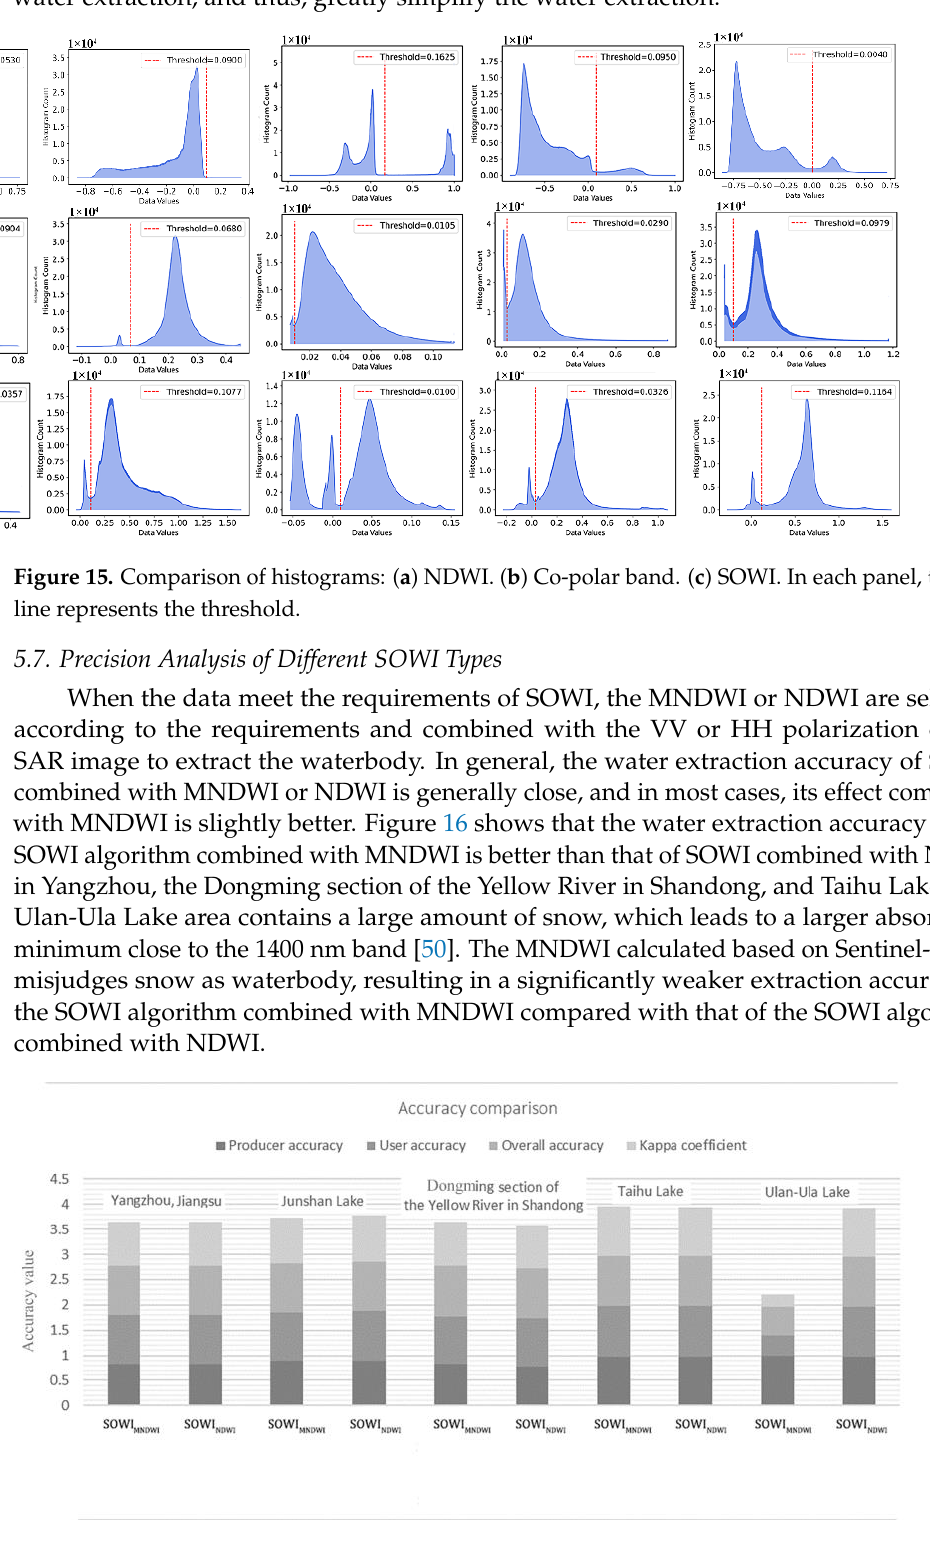
Figure 16. Accuracy comparison of SOWI algorithm combined with NDWI and MNDWI in five study areas.